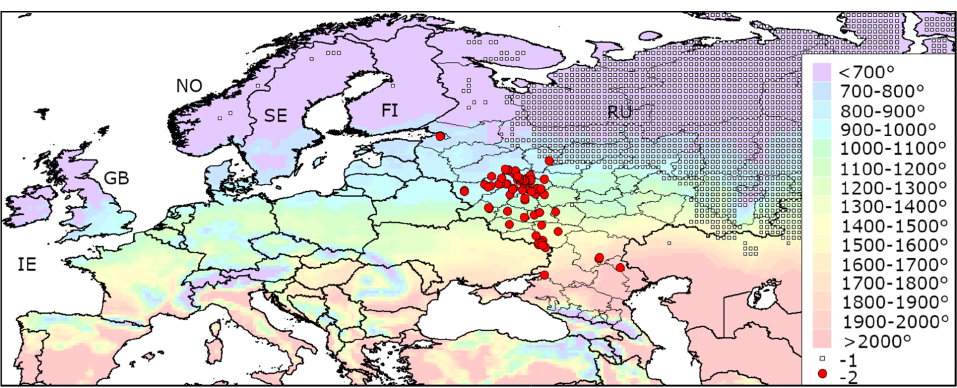
Figure 9. Distribution minimum winter temperature and heat availability in Europe. Mean AGDD 10 per year in 2003–2020 is indicated with colours (see the legend). 1—territories, which are not suitable for Agrilus planipennis establishment because of the extreme winter cold [15], 2—localities of A. planipennis . FI—Finland, GB—Great Britain, IE—Ireland, NO—Norway, RU—Russia,